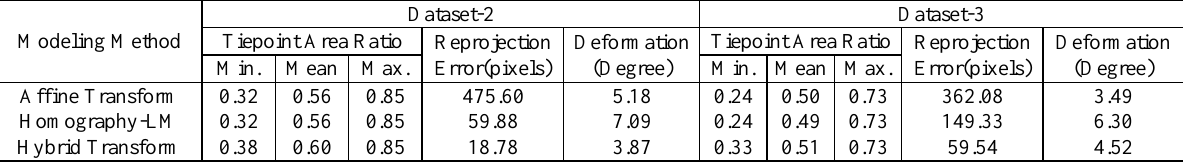
Table 1. Transformation estimation accuracy for Dataset-2 and -3.